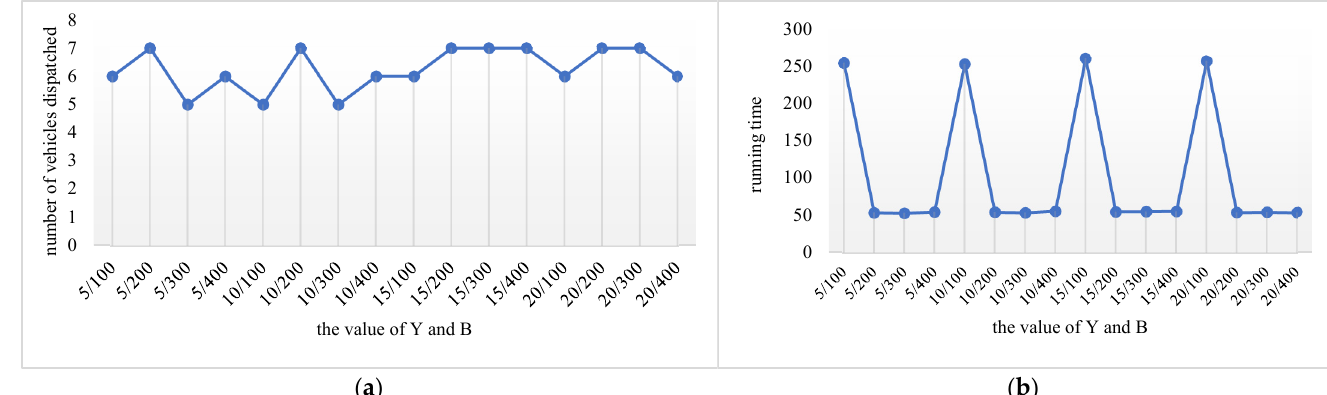
Figure 7. The experimental results of parameters. ( a ) The number of vehicles with different values of B, Y. ( b ) Running time with different values of B, Y.